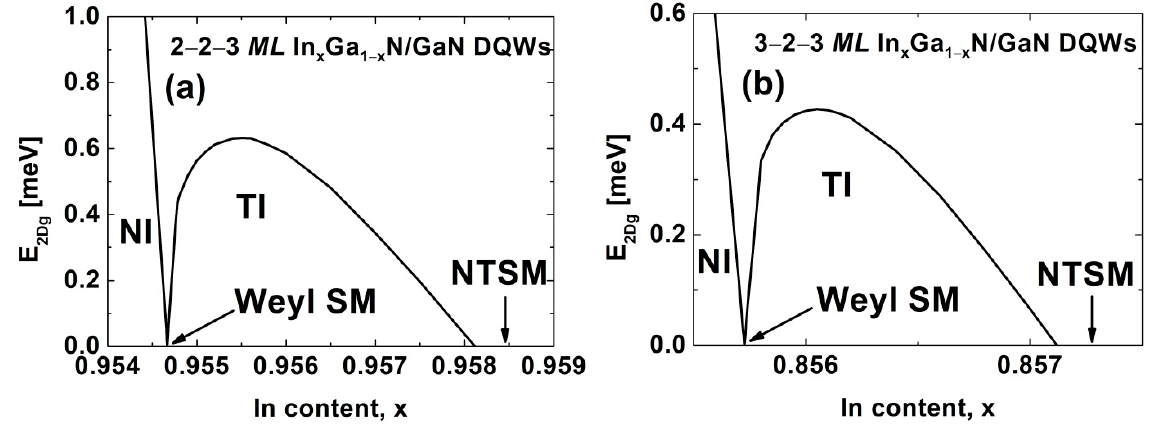
Figure 3. The E 2 Dg as a function of the In content in the QWs, for In x Ga 1 − x N/GaN DQWs with ( a ) L qw , A = 2 MLs , L qw , B = 3 MLs , and L ib = 2 MLs ; and ( b ) L qw , A = 3 MLs , L qw , B = 3 MLs , and L ib = 2 MLs